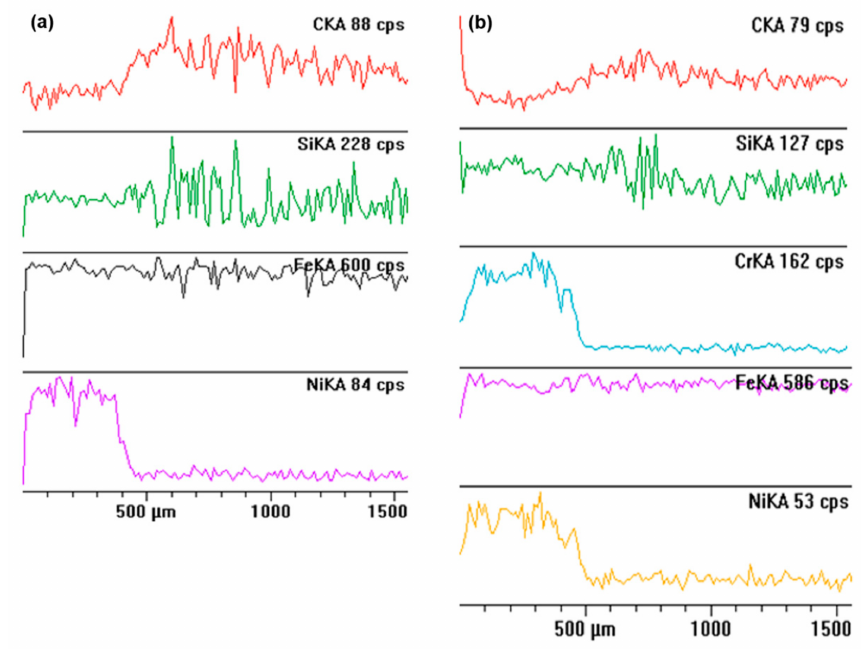
Figure 12. The distribution of investigated elements on the section from the surface to the core material for the cultivator coulter after laser implementation of alloyed nickel ( a ) and a combination of nickel and chromium ( b ) achieved with an EDS